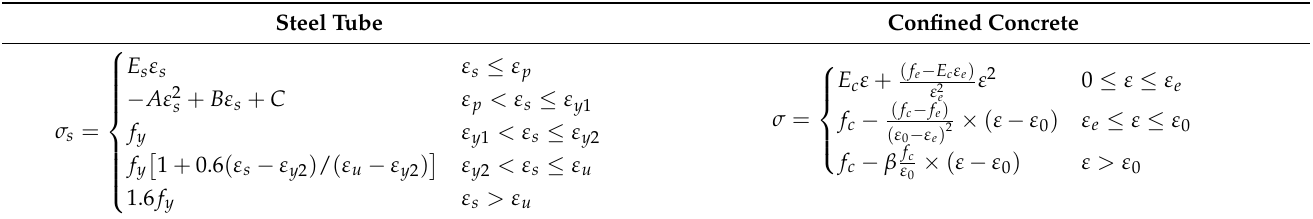
Table 4. Constitutive model of FEM.